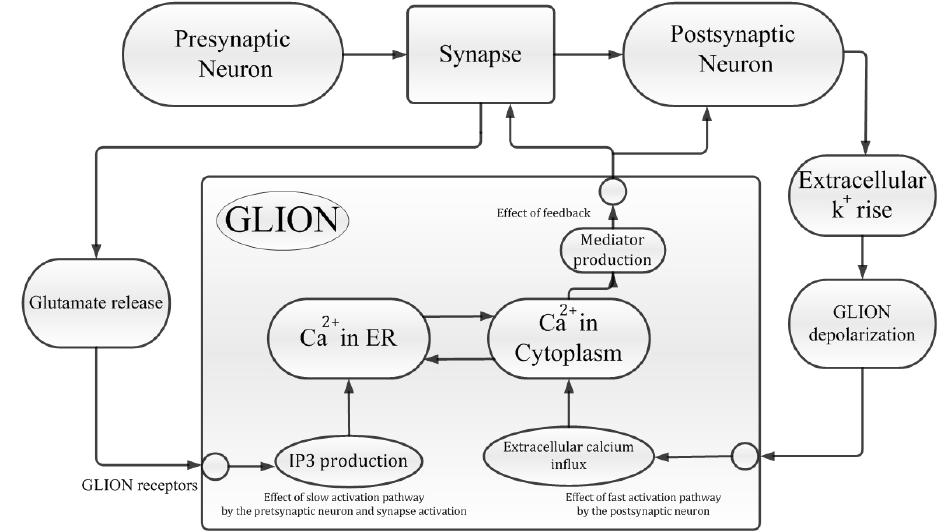
Figure 1. Functional structure of neural–glial